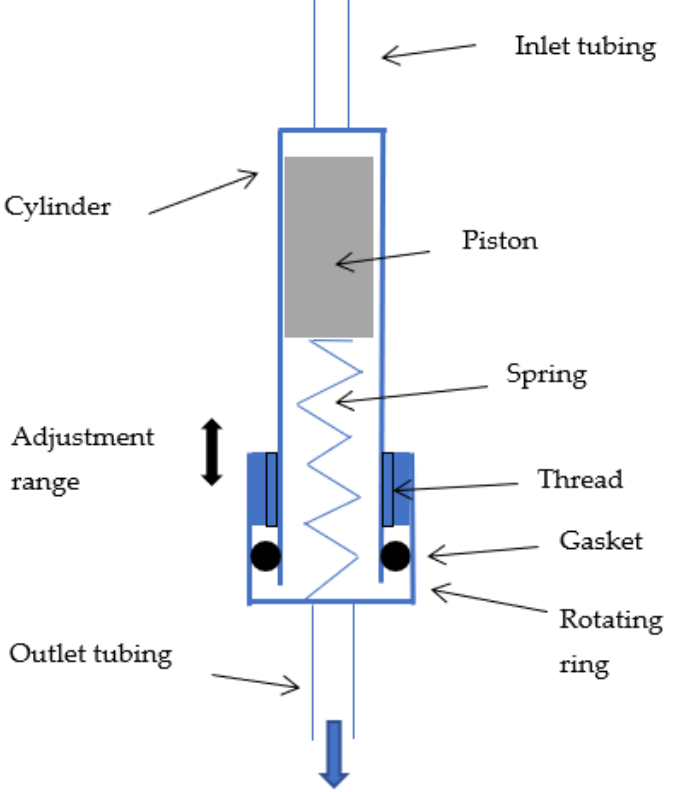
Figure 8. Adjustable flow-control spring valve with a rotating ring that allows the spring preload to be changed manually. A gasket between the ring and the cylinder is used to prevent leakage.